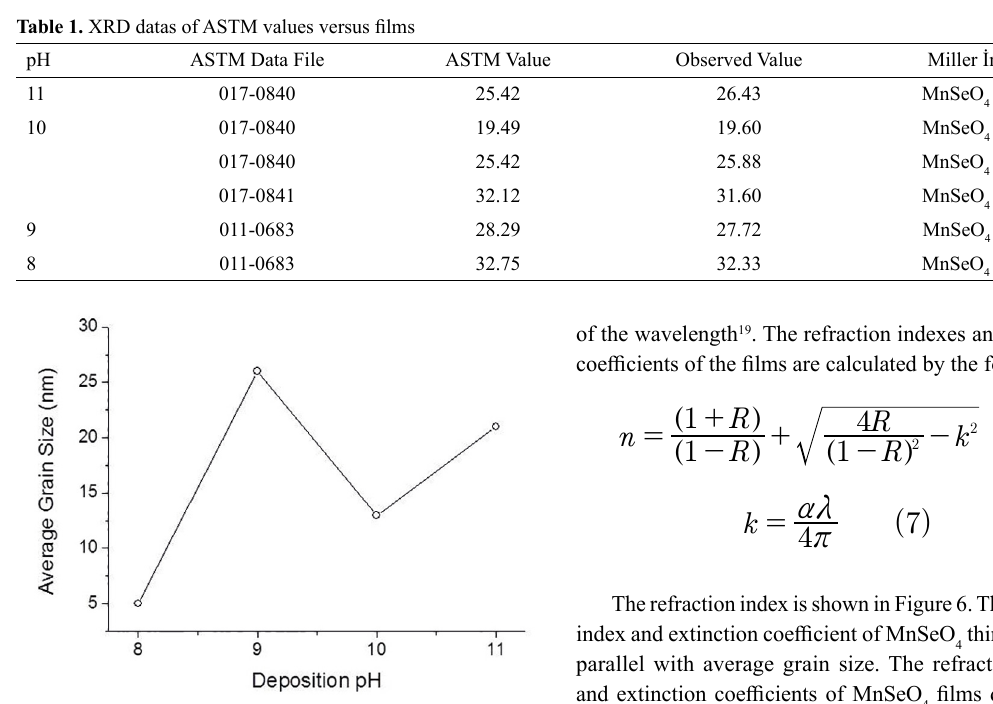
Figure 2. The grain size (D) of MnSeO various pH levels